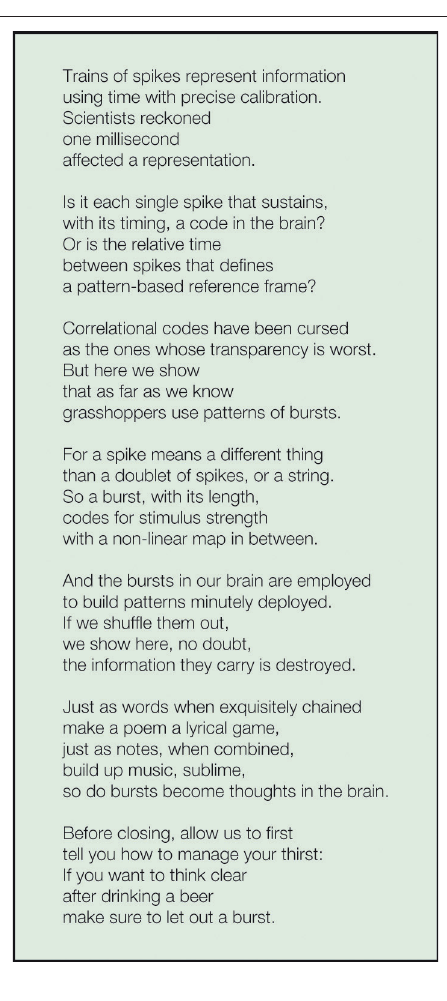
Figure 4 | A burst of rhymes to close, and complement the